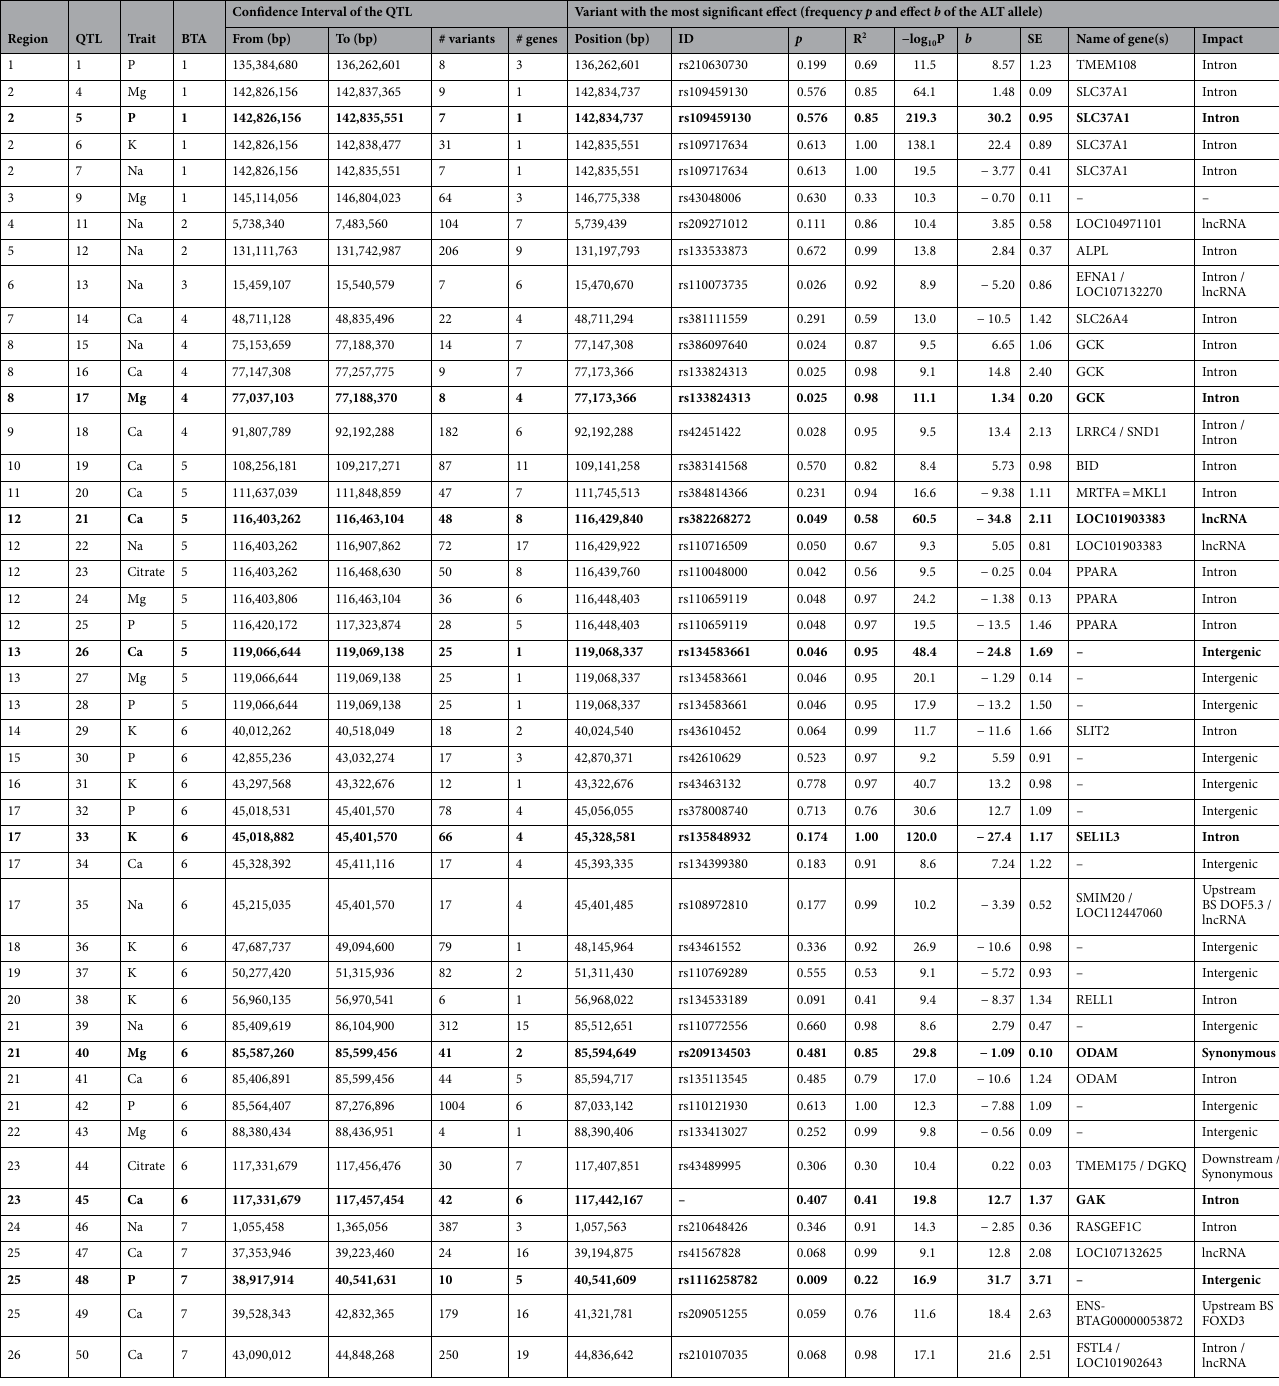
Table 3. QTL identified for milk mineral and citrate content on Bos taurus (BTA) autosomes 1 to 10 (when a QTL region affected multiple traits, the most significantly affected trait is indicated in